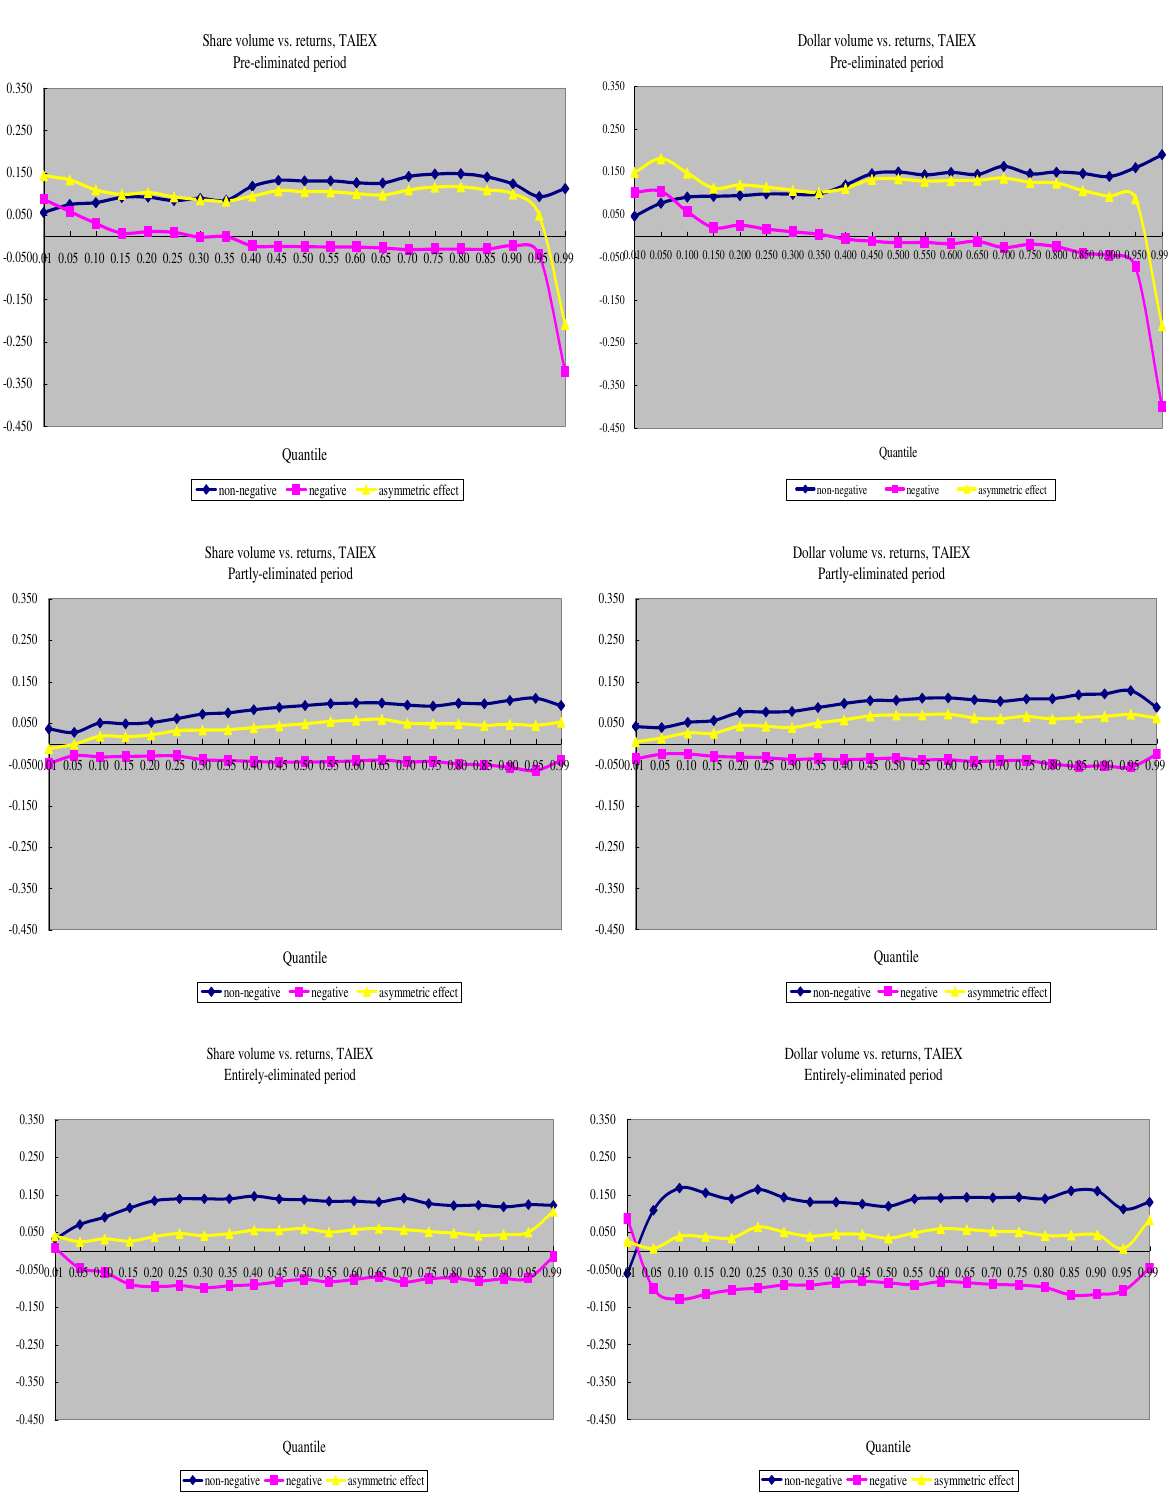
Fig. 5. Quantile regression estimates of volume-signed return correlation for TAIEX in three sub periods